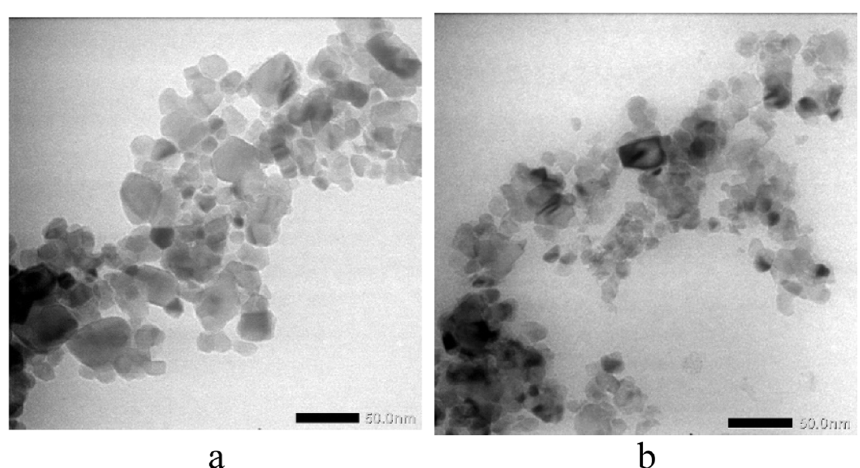
Fig. 6 The TEM images of a TiO 2 and b TiO 2 – Fe